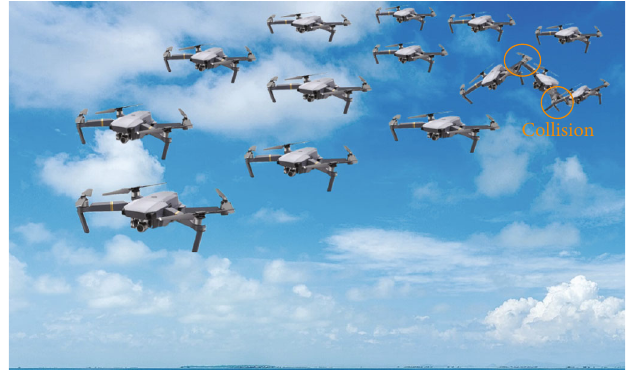
Figure 5: Collision occurred in the UAV